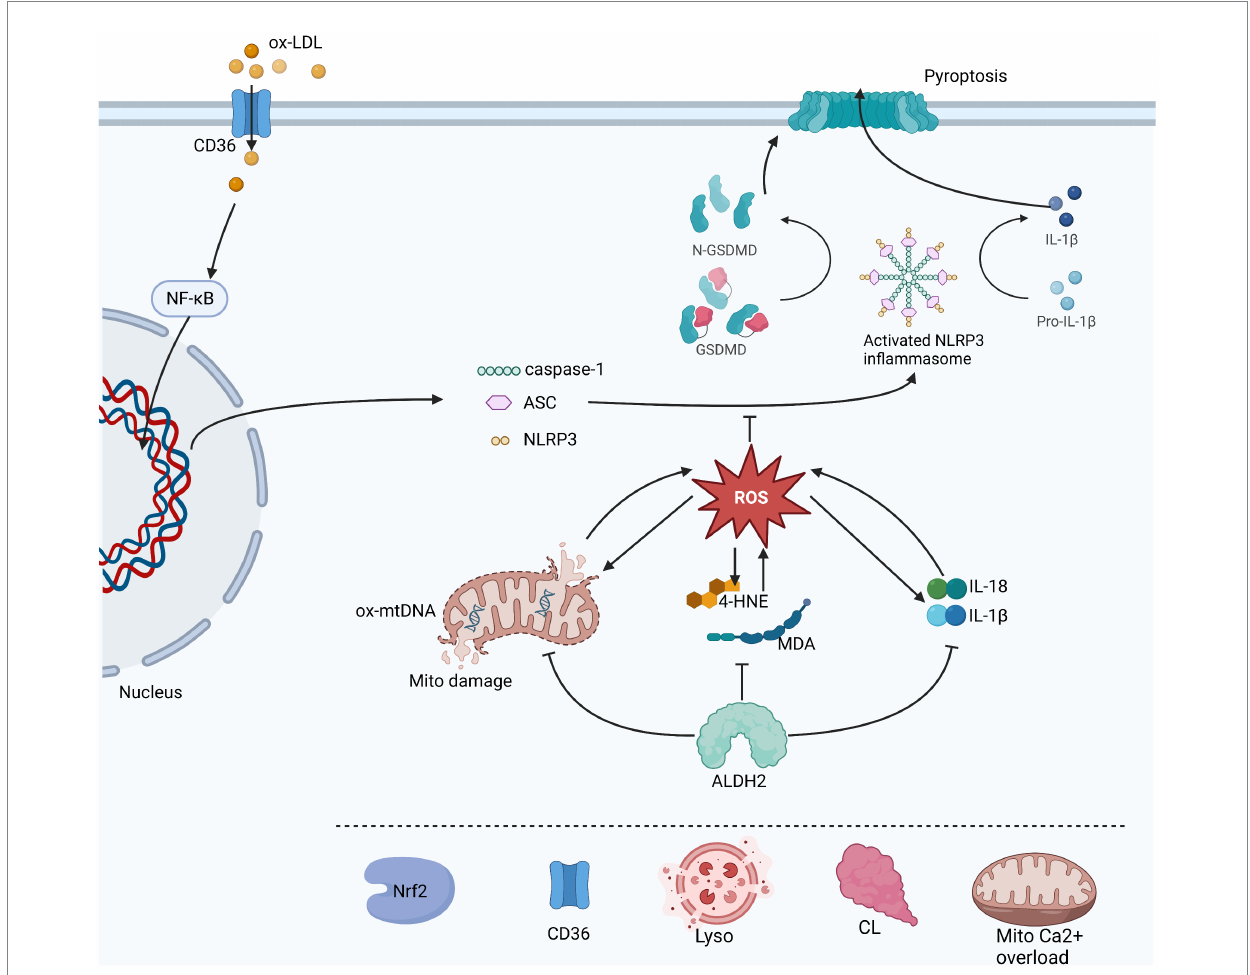
FIGURE 2 This is a figure of the process of NLRP3 inflammasome initiation and activation and the three pathways through which ALDH2 affects its activation are illustrated. ROS in direct inhibition is a common downstream of oxidative stress, inflammatory response and mitochondrial damage. In turn ROS also promotes these three aspects which are reflected by 4-HNE and MDA, mtDNA and IL-1 β and IL-18 levels. ALDH2 can protect mitochondria, metabolize toxic aldehydes and reduce the production of inflammatory factors. Other possible factors involved in the regulation of NLRP3 by ALDH2 include Nrf2, lysosomal instability, cardiolipin (CL), mitochondrion Ca 2+ overload and CD36.The sharp arrow indicates promotion, and the horizontal bar indicates